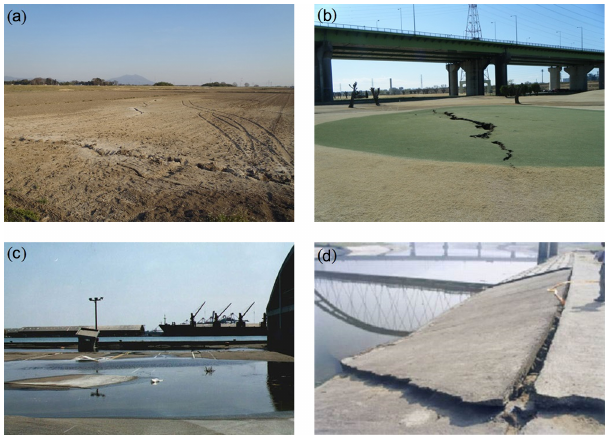
Figure 6. Photos showing liquefaction-induced hazards dur- ing the Chi-Chi earthquake and the 2011 T¯ohoku earthquake: (a) sand boils in Chikusei; (b) ground cracks at Arakawa River in Toda; (c) settlement at Taichung Port (http://www.ces.clemson.edu/ chichi/TW-LIQ/Liq-Album/Settlement-7.htm, last access: 10 De- cember 2016); (d) lateral spread induced failure of a dike in Nantou (http://www.ces.clemson.edu/chichi/TW-LIQ/Liq-Album/ LatSpread-3.htm, last access: 10 December 2016). Images © 2016 Clemson